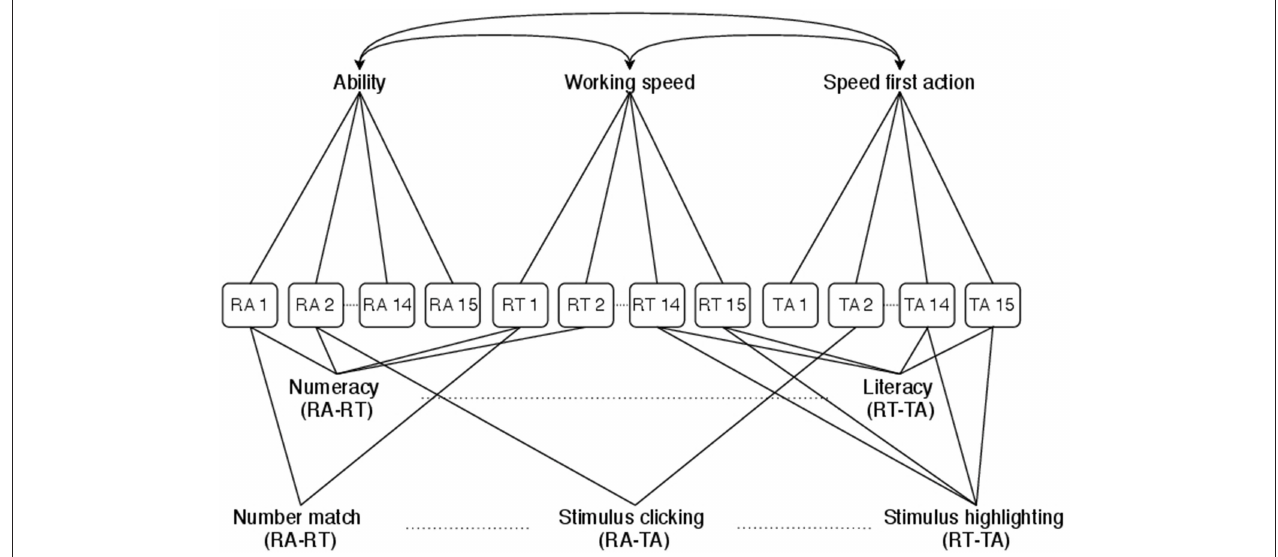
FIGURE 2 | Classification diagram for the PIAAC 2012 BCSM. The classification structure specifies dependences between scored responses and behavioral process data for varying item characteristics (domain and response mode) and a correlated latent factors structure. RA, RAs that underlie the scored dichotomous responses; RT, total RTs per item; TA, times to first action per